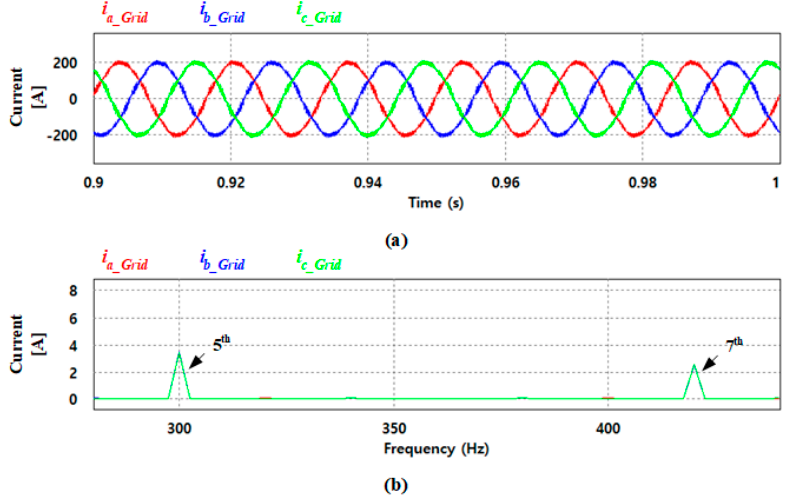
Figure 13. Simulation waveforms when applying the conventional method: ( a ) output current, ( b )FFT analysis result.